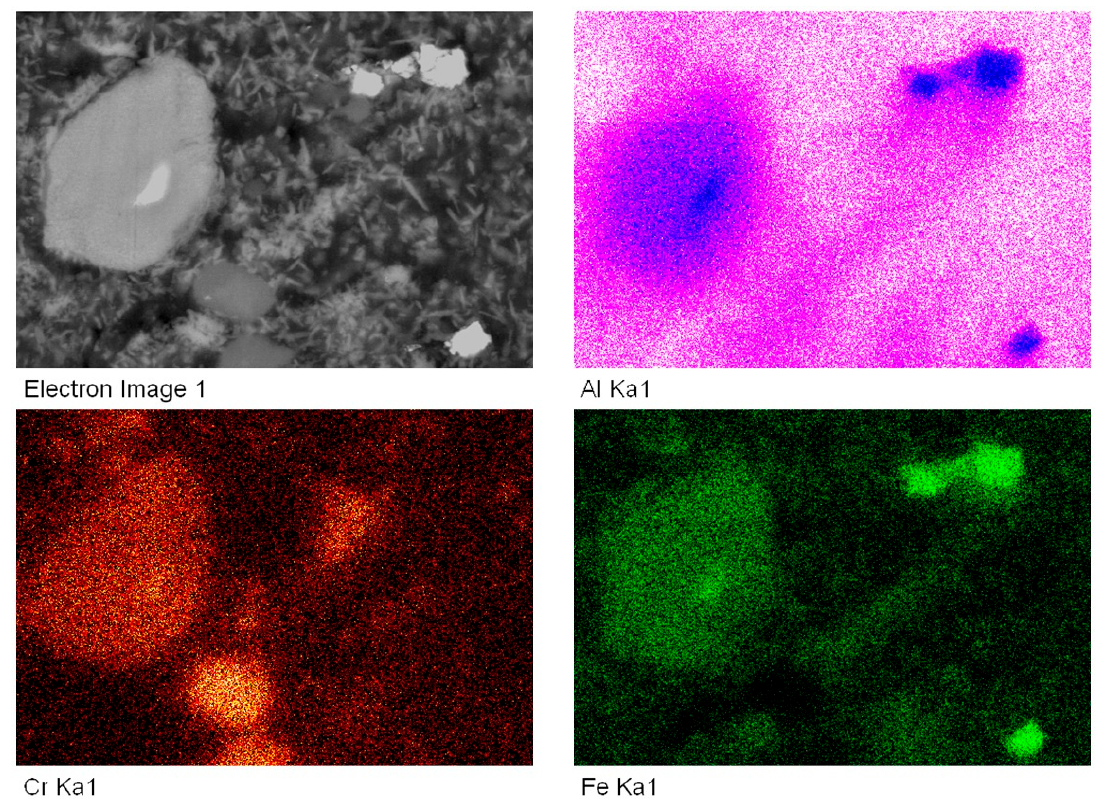
Figure 3. SEM mapping of the sintered bulk Al-10 wt. % Fe-5 wt. % Cr sample obtained from 150 h milled powder.